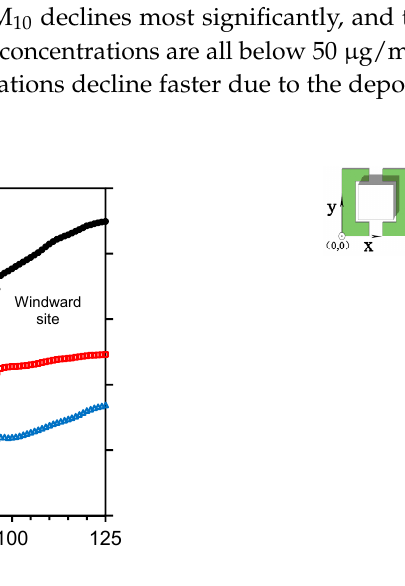
Figure 10. Relationship between oncoming wind speed and average indoor particle concentrations (wall porosity = 3.5%). This section focuses on the effect of window opening size on indoor particle concentrations. For clarity, indoor and outdoor PM 10 is compared when windows are fully open (wall porosity = 7.0%) and half open (wall porosity = 3.5%) in the baseline scenario (Figure 11). PM 10 is similar on the windward facade of the auditorium when windows are half or fully open. The airflow converges in